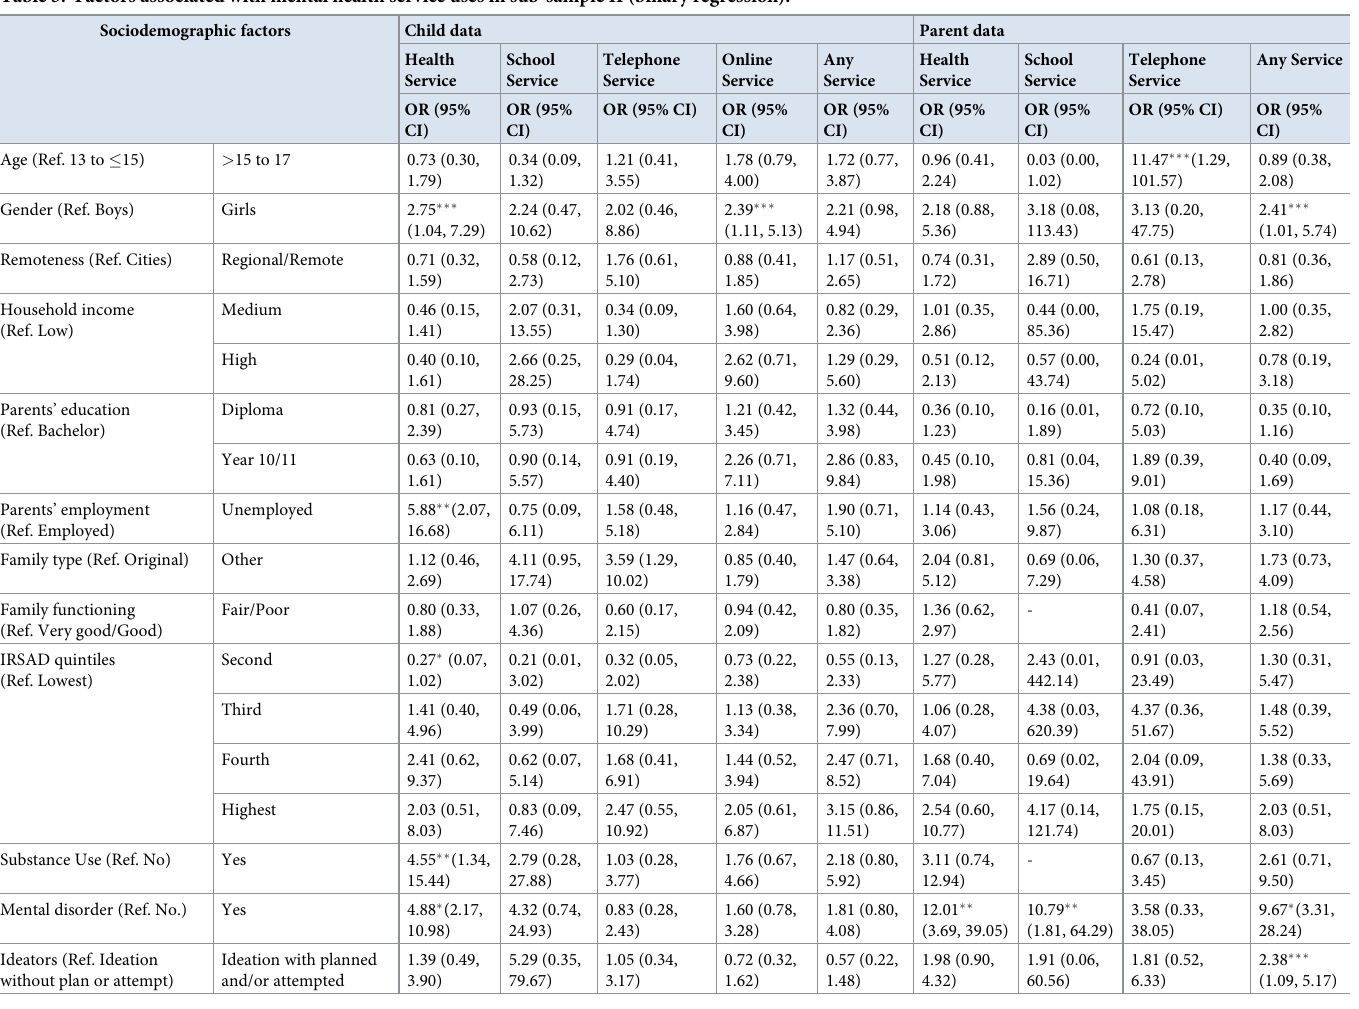
Table 5. Factors associated with mental health service uses in sub-sample II (binary regression). Sociodemographic